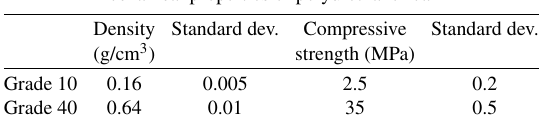
Table 1 Mechanical properties of polyurethane